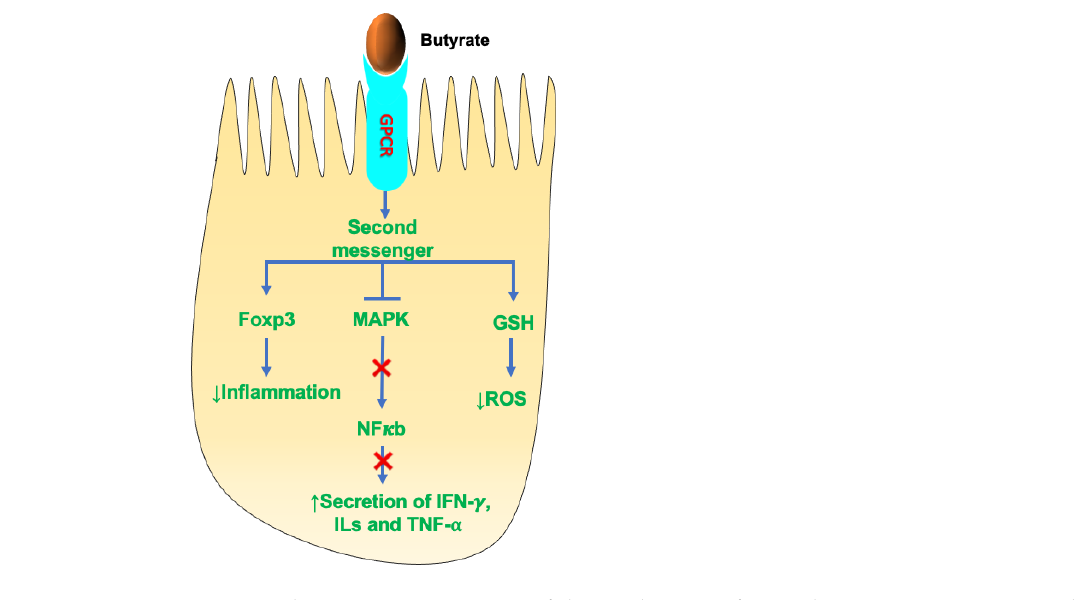
Figure 5. Schematic representation of the mechanism of SCFA butyrate on immune modulation. Butyrate binds to G-protein-coupled receptors (GPCRs), which activate various downstream signaling pathways involved in the regulation of inflammation and ROS production. SCFA, short-chain fatty acid; Foxp3, forkhead box protein P3; MAPK, mitogen-activated protein kinases; GSH, glutathione; NF- κ B, nuclear factor κ B; IL, interleukin; (IFN)- γ , interferon; TNF- α , tumor necrosis factor; ROS, reactive oxygen species. Upward arrow denotes increase and downward arrow denotes decrease.